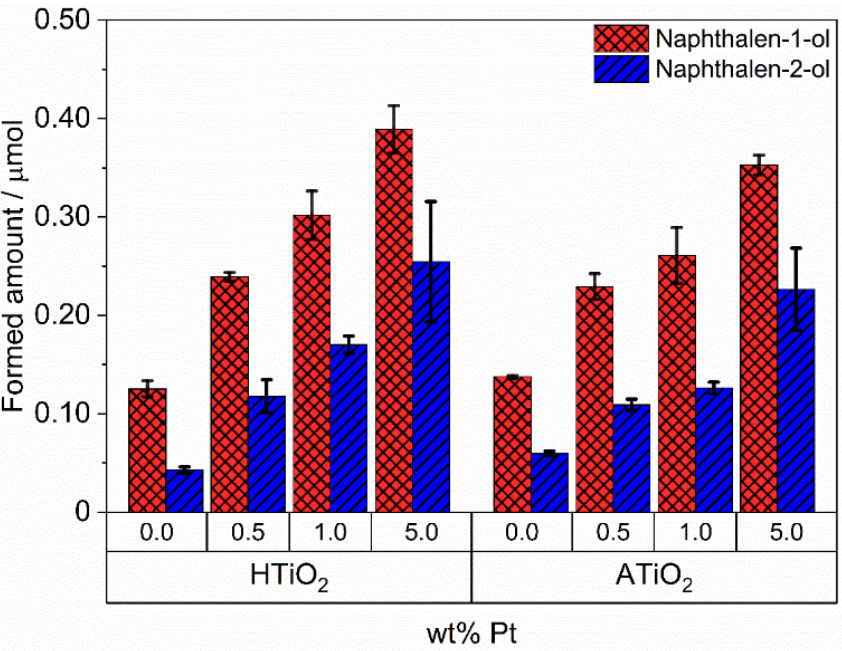
Figure 6. Photocatalytic formation of 1 ‐ naphthol and 2 ‐ naphthol during the reforming of naphtha